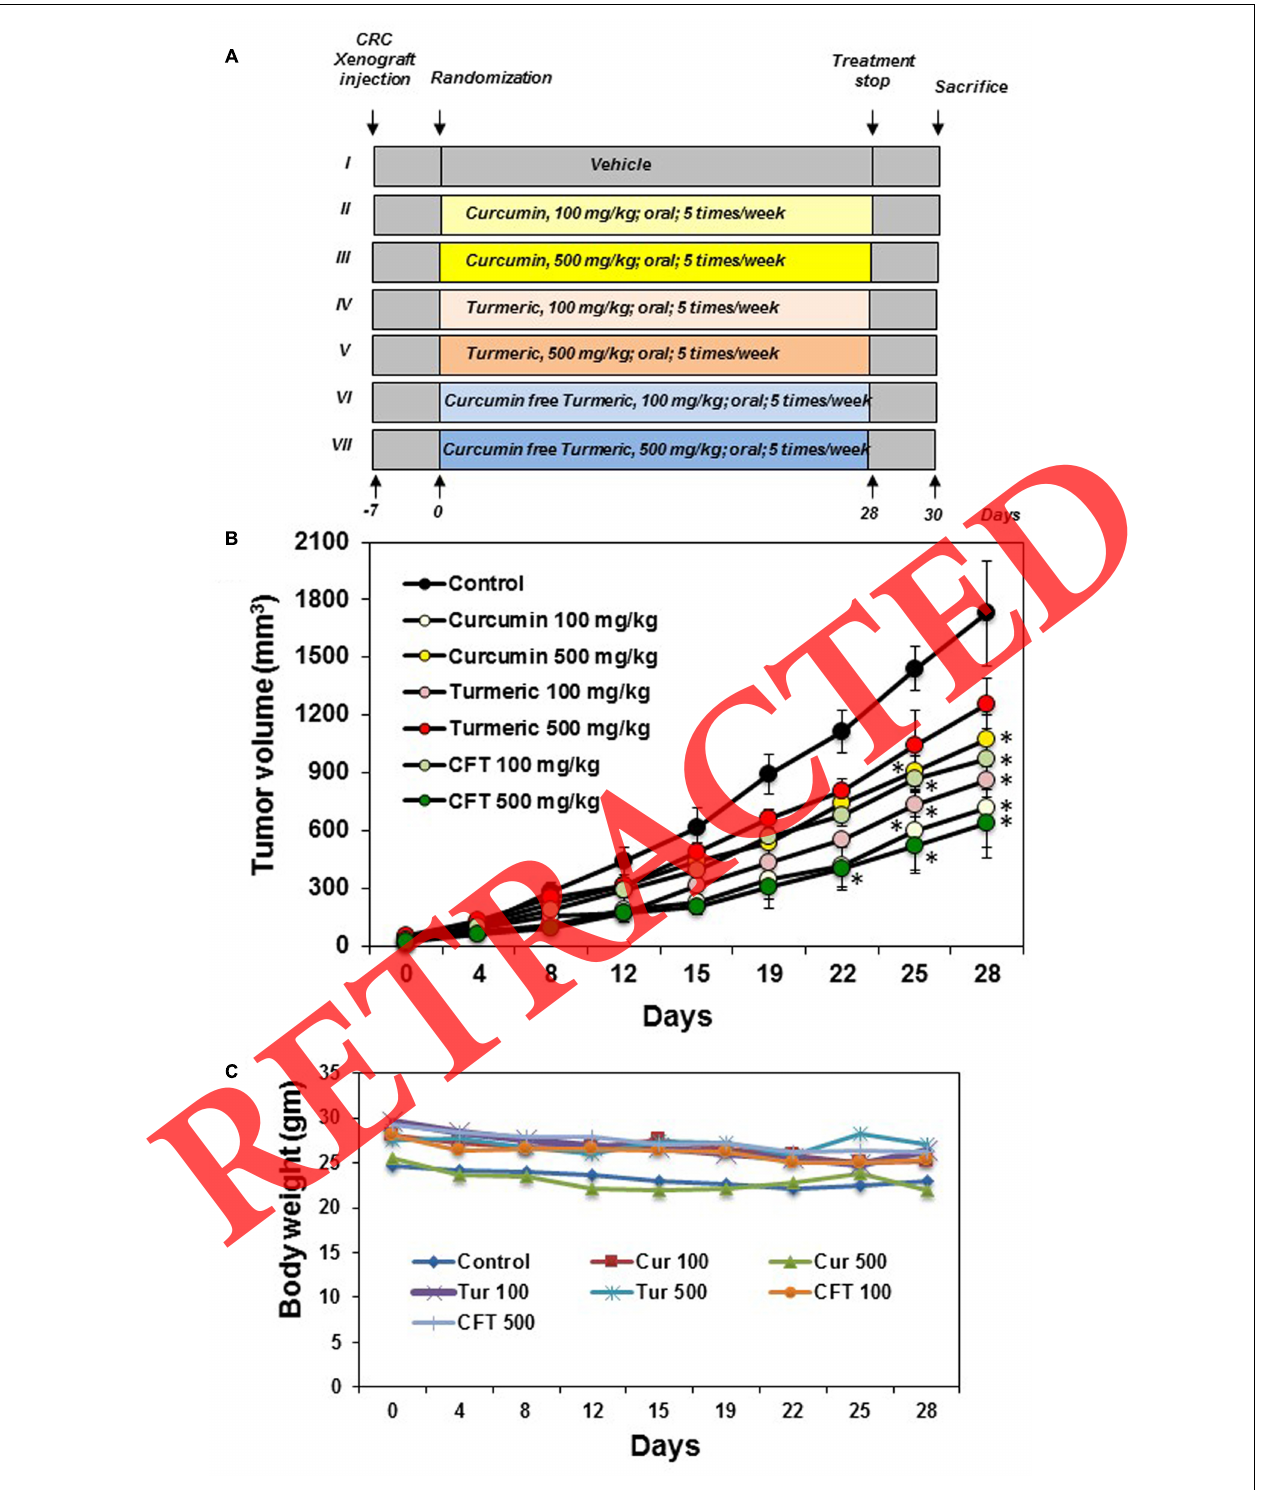
FIGURE 3 | Curcumin, turmeric, and CFT inhibit the growth of colorectal cancer (CRC) xenograft tumors in nude mice. (A) Schematic representation for the treatment schedule of mice with curcumin, turmeric, and CFT. (B) Tumor volume in the implanted mice was measured and plotted against time following drug administration. ∗ P < 0.05 vs. control; differences at other time points or between other groups were not significant by ANOVA with post hoc Tukey test. (C) Curcumin, turmeric, and CFT did not affect the body weight of the mice. The body weight of mice was measured twice weekly.